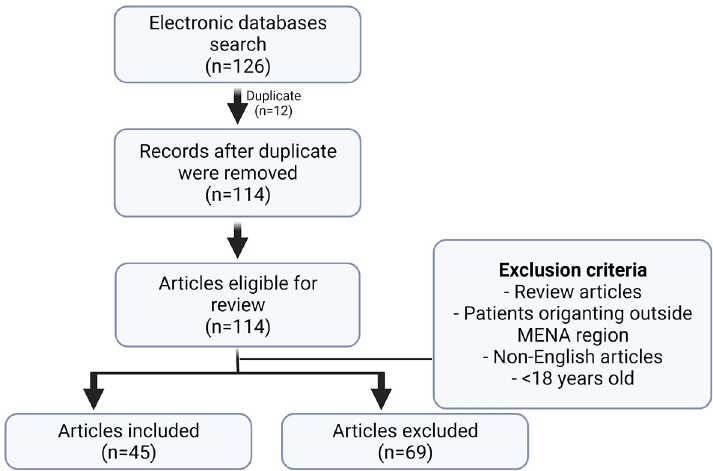
Figure 1. Schematic representation of the search method. Following the search from different databases, a total of 126 articles was retrieved, of which 12 were duplicates and another 69 articles did not meet the inclusion criteria. Studiesexcludedwerethosethat hadpatientpopulationsoriginatingoutside theMENAregion,review articles,non- English written articles, or studies where the patient population was under 18 years of